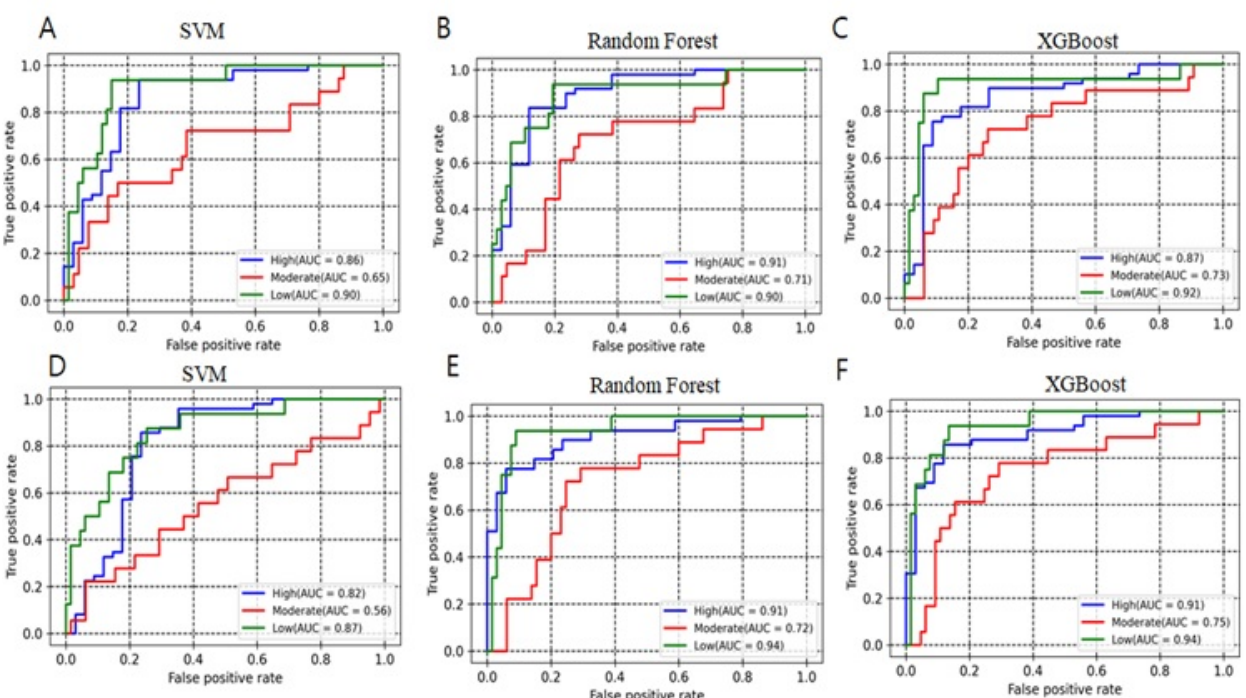
Figure 3. ROC curve showing the performance of multiclass models. ( A – C ) All descriptors set. ( D – F ) Selected descriptors (Boruta method).